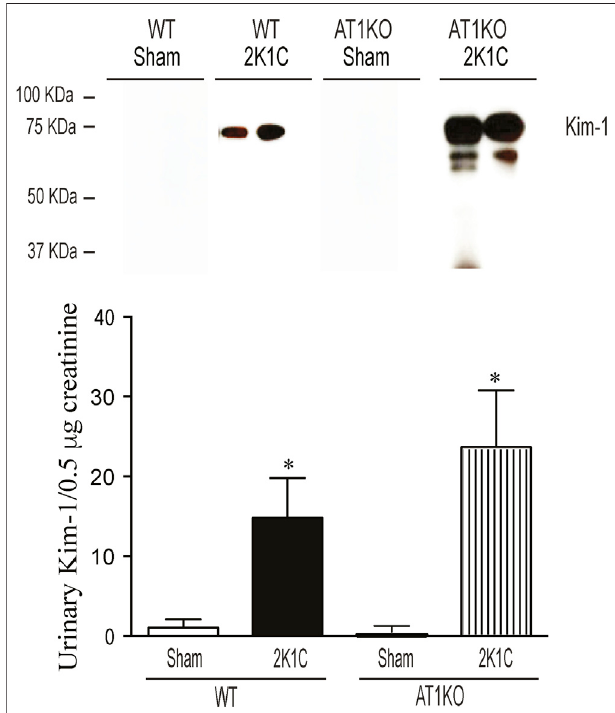
FIGURE 11 | Immunoblotting revealed increased expression of KIM-1 in the urine of WT and AT1KO mice undergoing 2K1C surgery. Urine volumes equivalent to 0. 5 µg creatinine was used for western blot analysis of urinary KIM-1 expression in the urine of WT and AT1KO mice undergoing 2K1C surgery. In each individual experiment, samples were loaded randomly in four gels. Two Immunoreactive bands from each group corresponding to KIM-1 were appropriately cropped and spliced as a representative of the result. In 2K1Cmice,KIM-1wasdetectedat75 kDa,whereasonlyfaintbandsforKIM- 1 were detected in the urine of sham. * p < 0.001 vs. Sham Each bar represents mean ± SEM (n (cid:2) 6 –